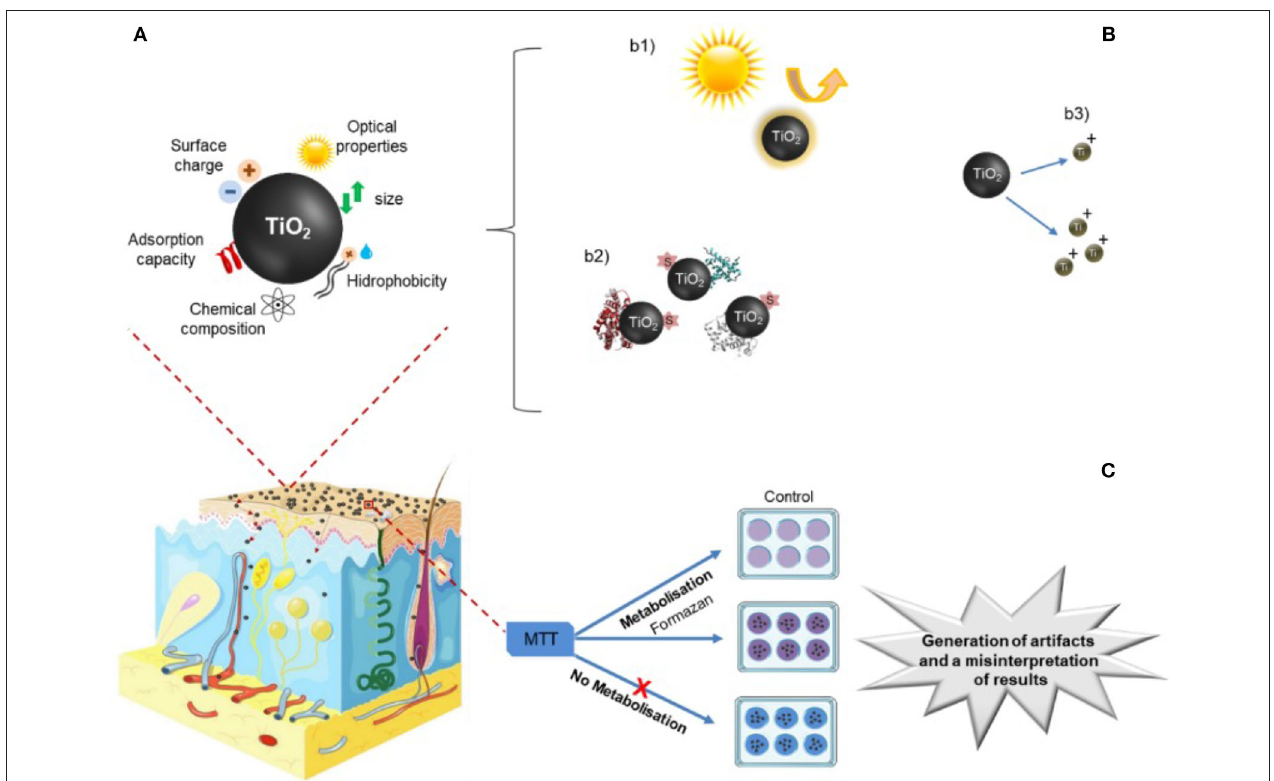
FIGURE 4 | Toxicological assays. (A) Physico-chemical characteristics of NPs TiO 2 NPs that possible interfere with the biological assays; that include (B) optical capabilities of TiO 2 NPs such as intrinsic absorbance and/or fluorescence (b1); adsorption of proteins, salts and dyes (s) to NPs (b2); and dissolution of NPs with the consequent release of metal ions to supernatant (b3). (C) Conventional MTT test analyzing TiO 2 NPs demonstrating that NPs can adsorb to MTT dye that avoid metabolization of reagents. Image adapted from: